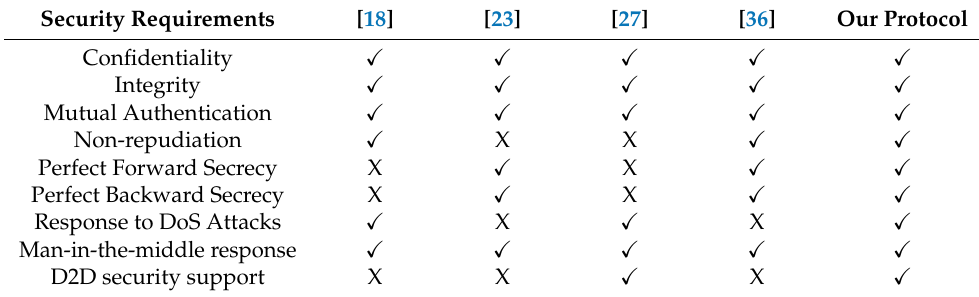
Table 5. The state-of-the-art comparison with existing protocols.